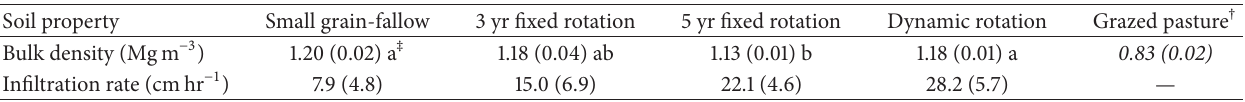
Table 1: Crop diversity effects on soil bulk density at 0–10 cm and infiltration rate for long-term crop and pasture treatments near Mandan, ND.